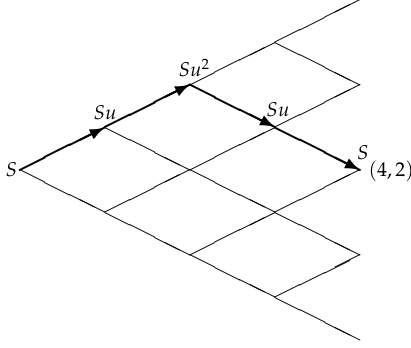
Figure 2. Trajectory τ max ( 4,2 ) for node ( 4,2 ) of the tree discretizing the asset value in regime